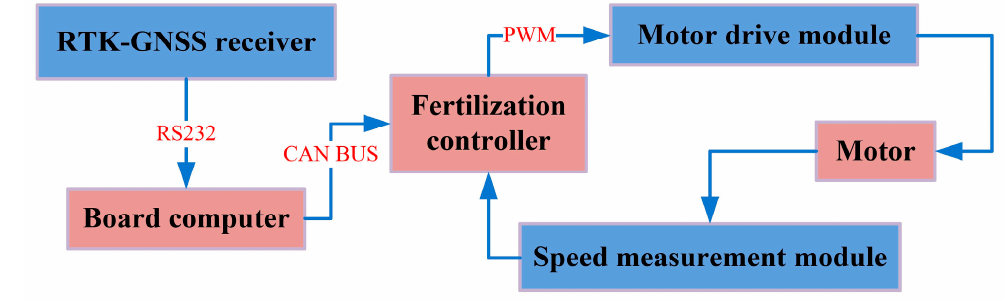
Figure 3. Principle of fertilization control system.